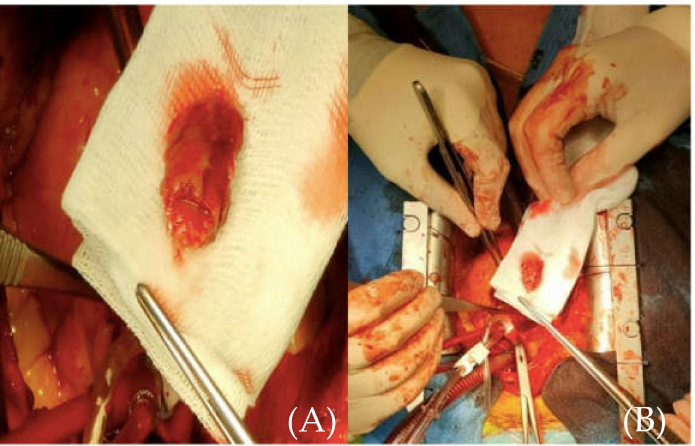
Figure 6. ( A ) (close-up image of the thrombus) and ( B ) (size referencing) intraoperative aspect of the removed